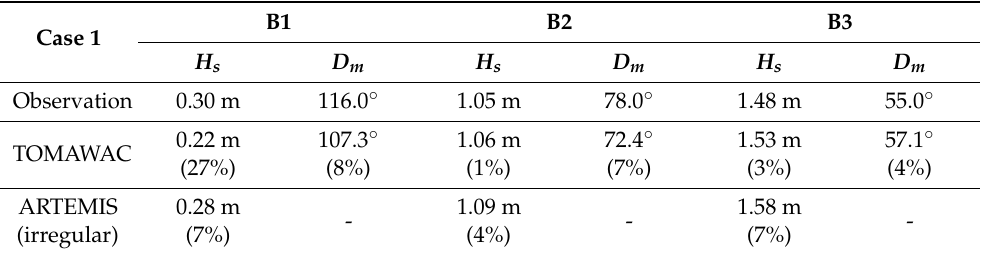
Figure 7. Distributions of wave heights modeled by ( a ) TELEMAC–TOMAWAC and ( b ) TELEMAC– ARTEMIS, Case 1. Table 2. List of the wave parameters calculated from the model results, Case 1. The percentages in the parenthesis are the model errors from the